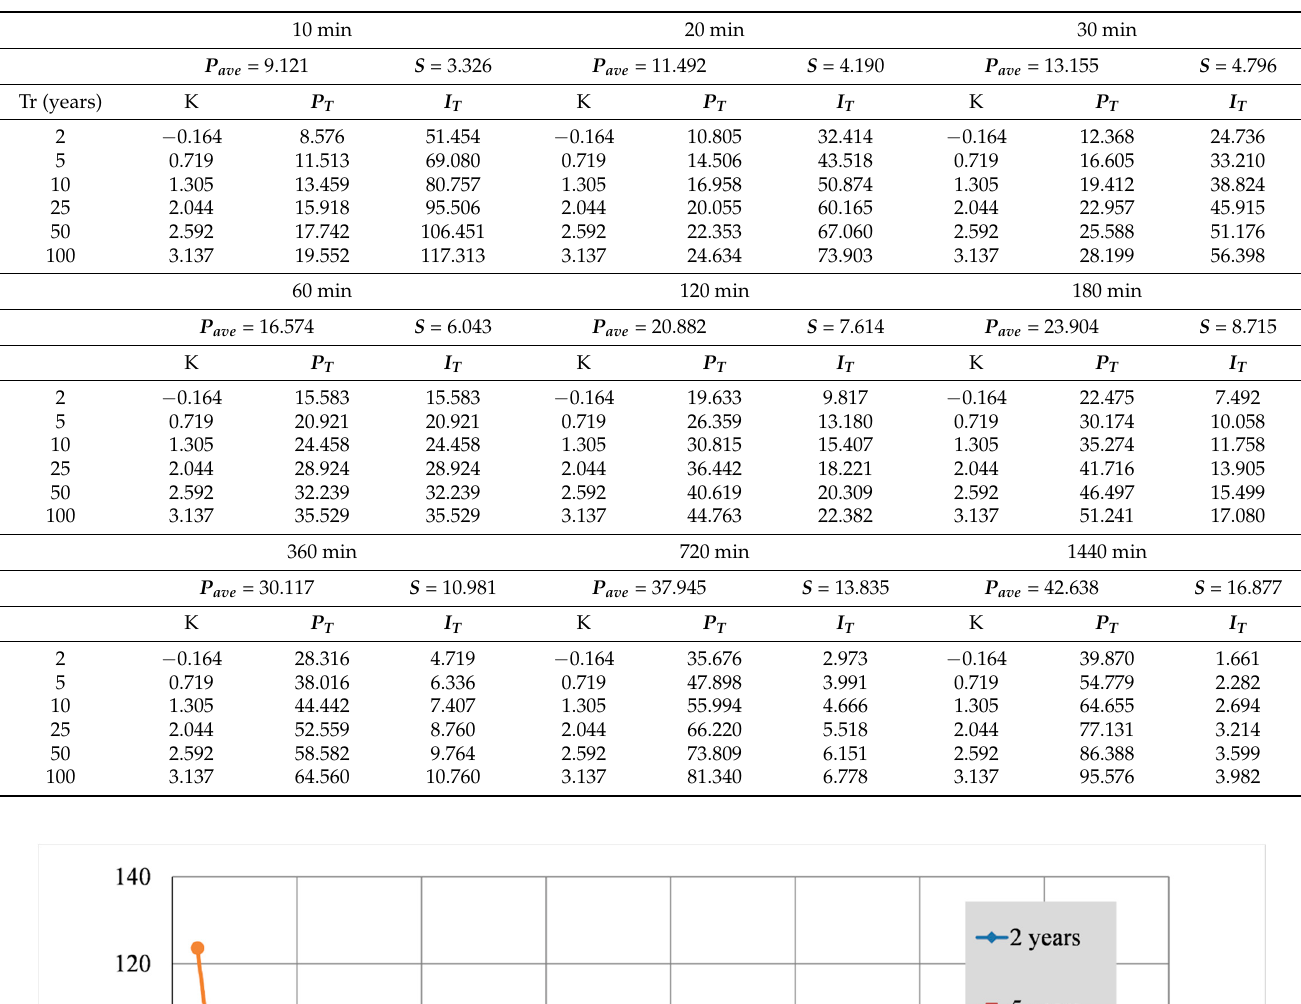
Table 2. Rainfall intensities calculated using the Gumbel method for various standard time scales and return periods.